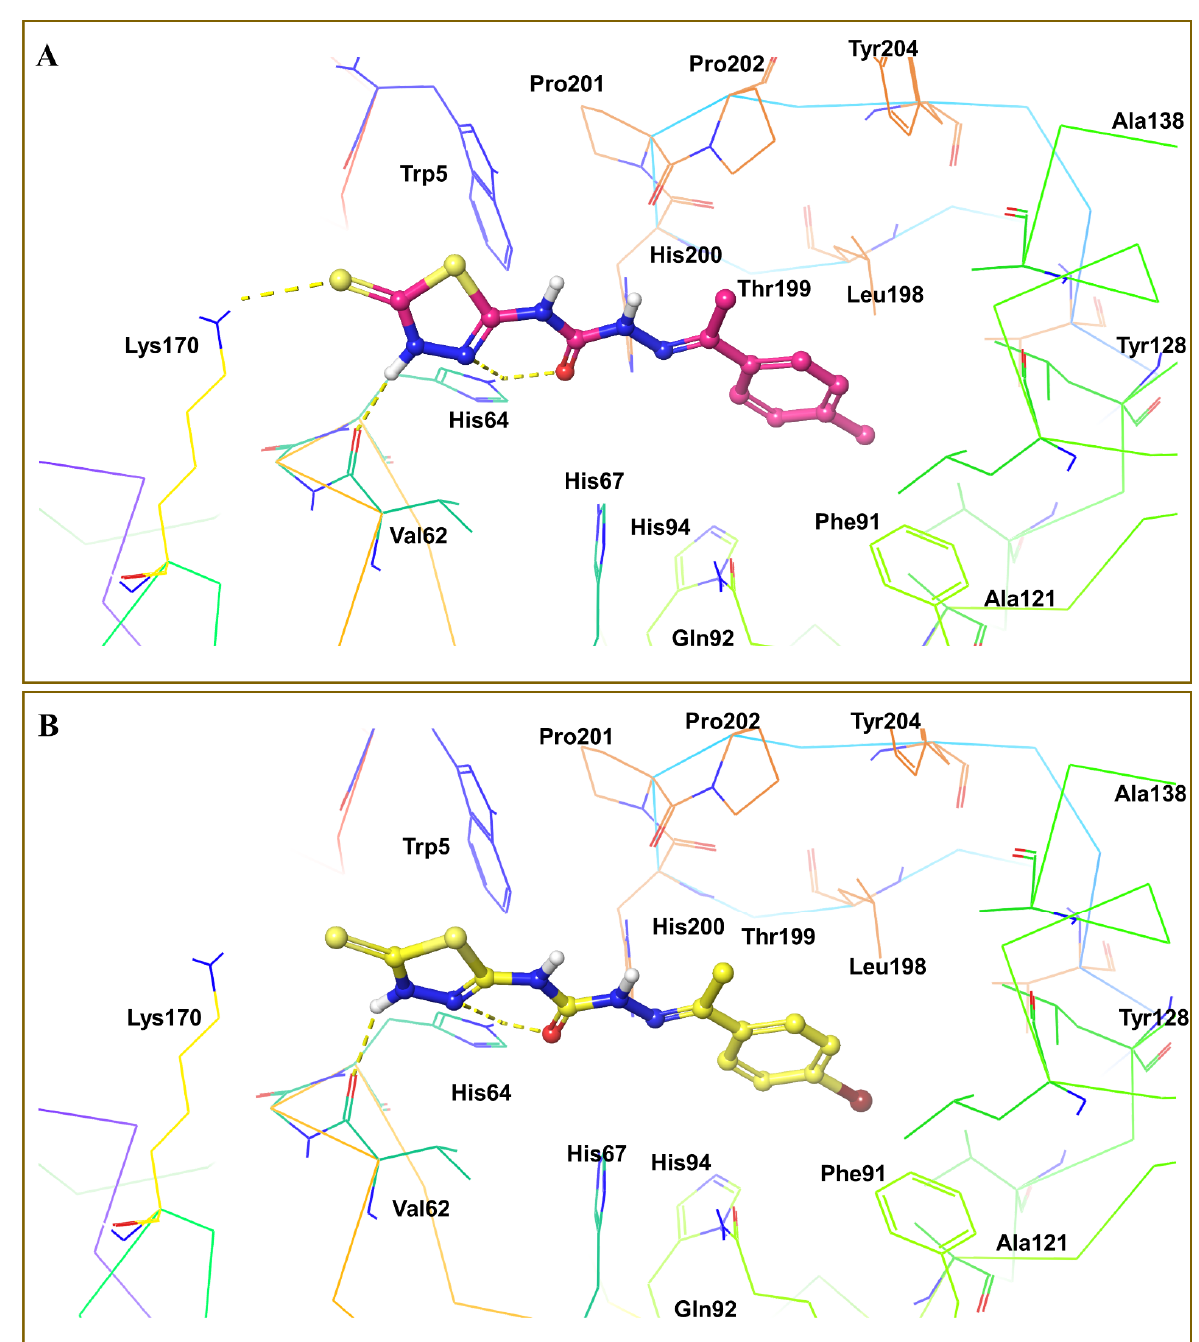
Figure 7. ( A ) 3D interactions of compound 4o with different amino acids His64, Val62, Lys170 at the binding site of receptor 6g3v. ( B ) 3D interactions of compound 4s with different amino acids His64, and Val62 at the binding site of receptor 6g3v.